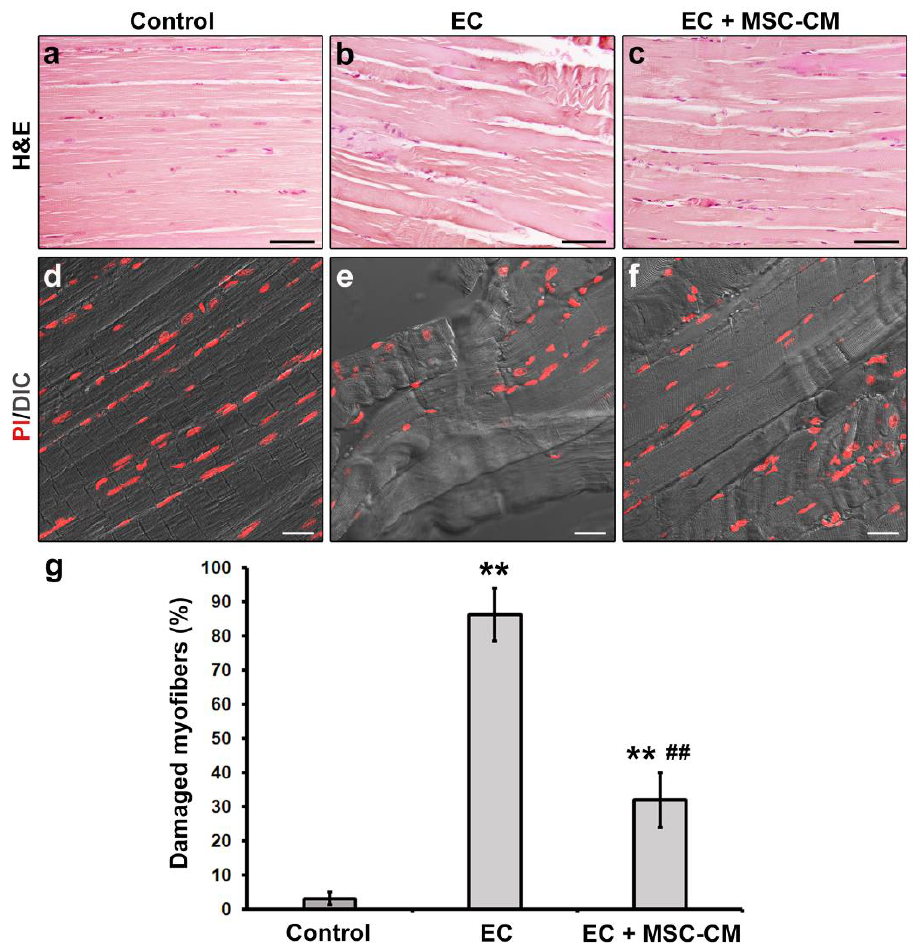
Figure 1. Morphological analyses of formalin-fixed and paraffin-embedded tissue sections from control murine EDL muscles, EDL muscles damaged by ex vivo forced eccentric contraction (EC) and EDL muscles damaged by EC in the presence of bone marrow-mesenchymal stromal cell (MSC) conditioned medium (EC + MSC-CM). ( a – c ) Representative light microscopic images of longitudinal muscle tissue sections stained with hematoxylin and eosin (H&E). Scale bars = 50 µ m. ( d – f ) Representative superimposed confocal fluorescence and differential interference contrast (DIC, grey) images of muscle tissue sections showing nuclei stained with propidium iodide (PI, red). Scale bars = 25 µ m. ( g ) Quantitative analysis of the percentage of damaged myofibers. Values are mean ± SEM. ** p < 0.01 vs. control, ## p < 0.01 vs. EC.